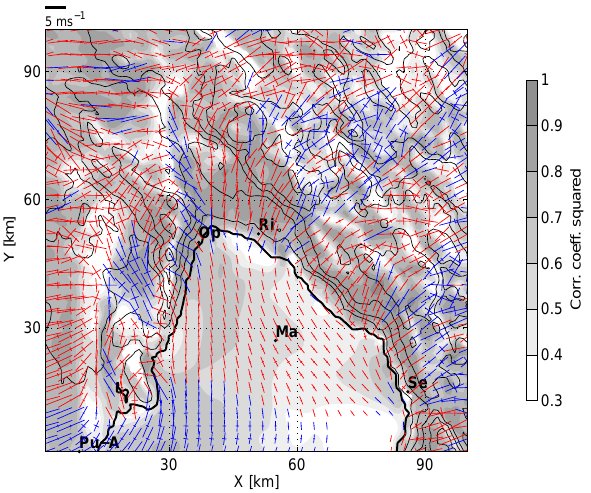
Fig. 7. Same as in Fig. 6 (bottom) but for the simulation without islands (A